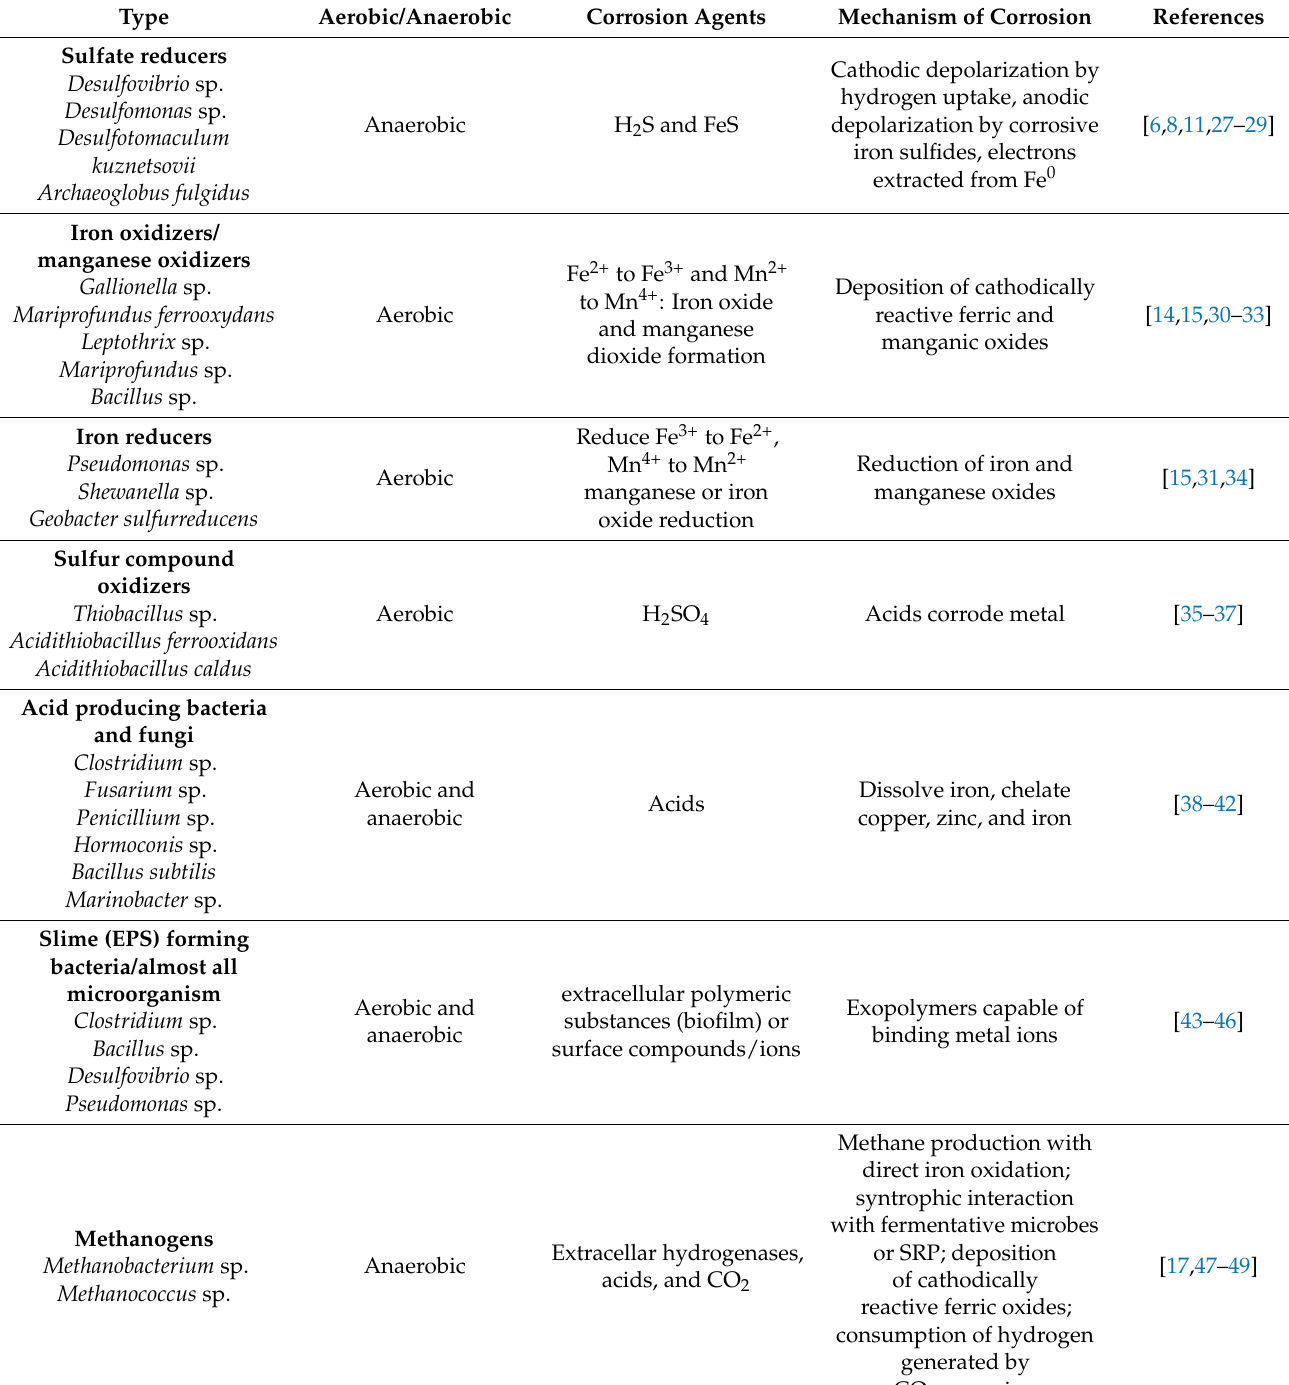
Table 1. MIC causing microorganisms and their characteristics, summarized and modified on the basis of